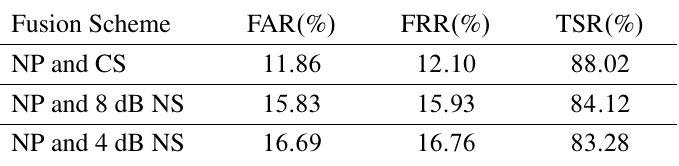
Table 9. Verification rate of match score level fusion of noisy palmprint using ICA II MM with speech (clean and